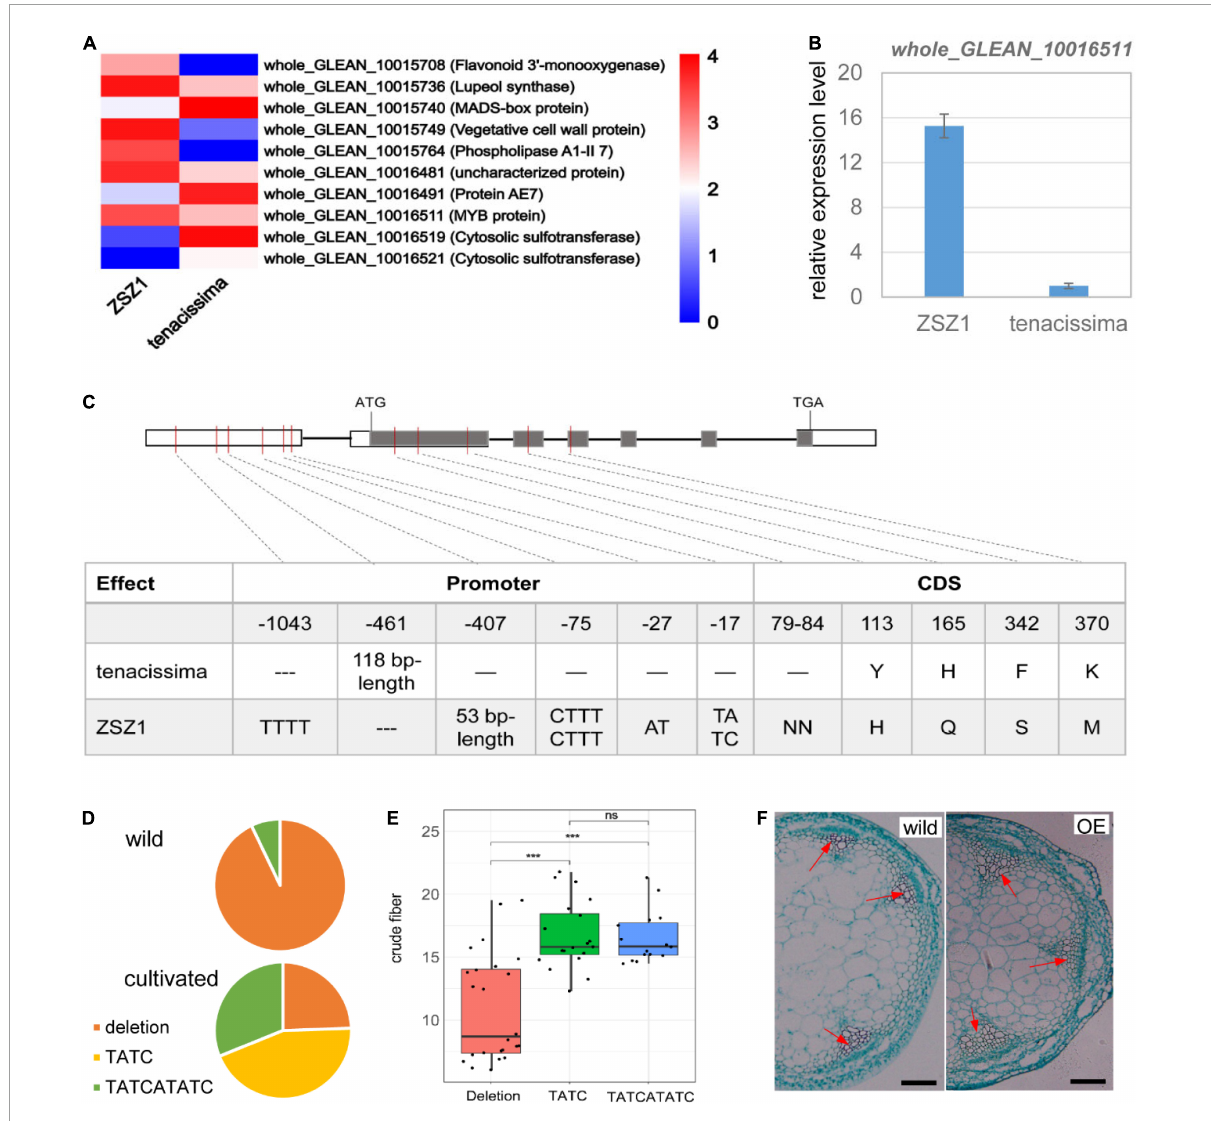
FIGURE4 Functional characterization of whole_GLEAN_10016511 . (A) Differentially expressed genes between ZSZ1 and tenacissima leaves. whole_GLEAN_10015708 , whole_GLEAN_10015736 , whole_GLEAN_10015740 , whole_GLEAN_10015749 , and whole_GLEAN_10015764 are in the CF7 region, whereas all others are from the CF13 region. Gene annotation was indicated in brackets following the gene ID. whole_GLEAN_10016511 expression was downregulated in the tenacissima leaves. (B) Relative expression level of whole_GLEAN_10016511 in the leaves of ZSZ1 and tenacissima. (C) Sequence variations of whole_GLEAN_10016511 in the two parents, ZSZ1 and tenacissima. Gray and white rectangles indicate the coding sequence (CDS) and promoter region, respectively. The thick black lines before the inter-exon region represent the putative intron region. The vertical molding in the gene indicates variation in the corresponding position of the gene. The tables under each figure show the detailed sequence variations in CDS and the corresponding amino acid change for each gene. (D) Allelic variation frequency at the 17-bp upstream of whole_GLEAN_10016511 CDS in wild and cultivated ramie. Orange, yellow, and green parts in each pie graph indicate the allelic frequency of deletion, insertion by TATC, and insertion by TATCATATC in the wild and cultivated groups. (E) Boxplot showed the difference in the crude fiber content of leaves among three groups whose accessions harbor different genotypes at the 17-bp upstream of whole_GLEAN_10016511 CDS. *** Indicates the significant difference at the level of 0.001, and ns indicates no significant difference. (F) Light microscope observation of transected stems of wild and whole_GLEAN_10016511 -overexpressing (OE) Arabidopsis . Arrows indicate the fiber cells of xylem regions. Scale bar = 200 µ